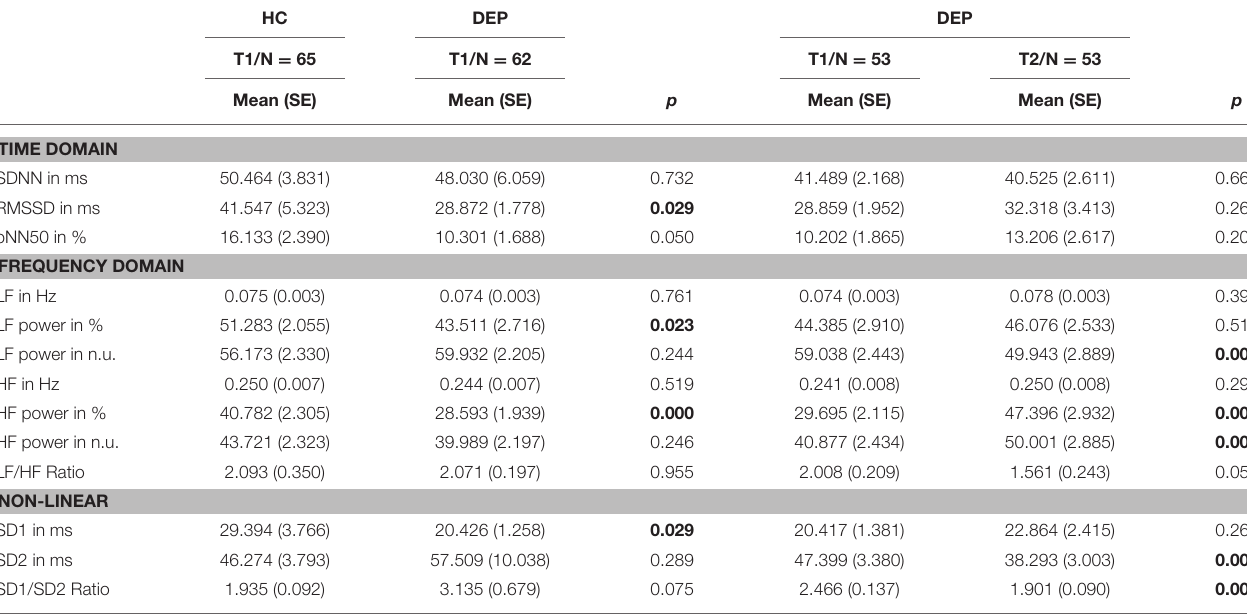
TABLE 2 | Heart Rate Variability in healthy controls (HC) and MDD patients (DEP) and MDD patients before (T1) and after 2 weeks of antidepressant treatment